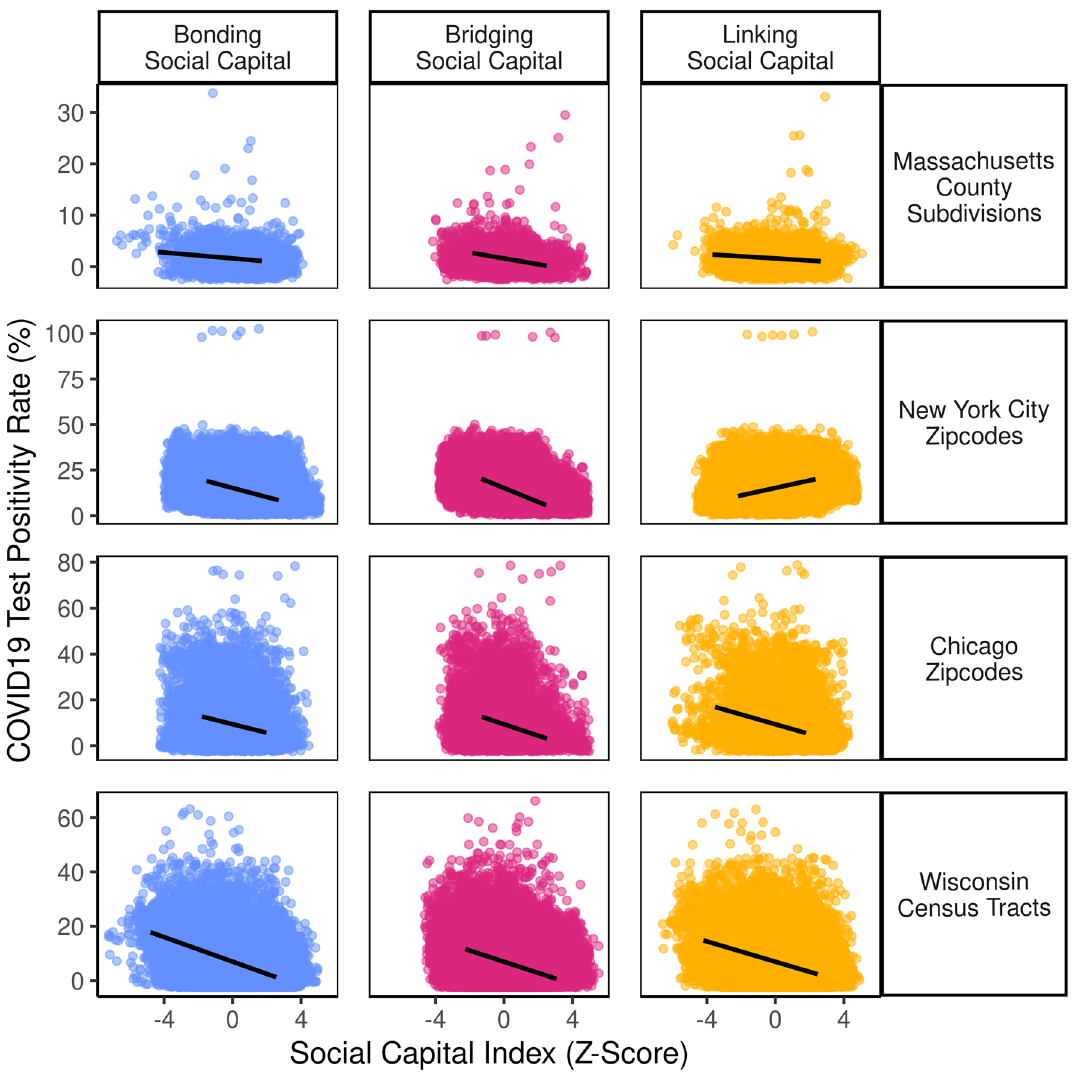
Figure 6. Social capital (mostly) reduces COVID-19 spread. Bivariate Scatterplots of social capital index scores compared to test positivity rates over, with lines of best fit depicting weak-to-strong negative associations for all except linking social capital in New York